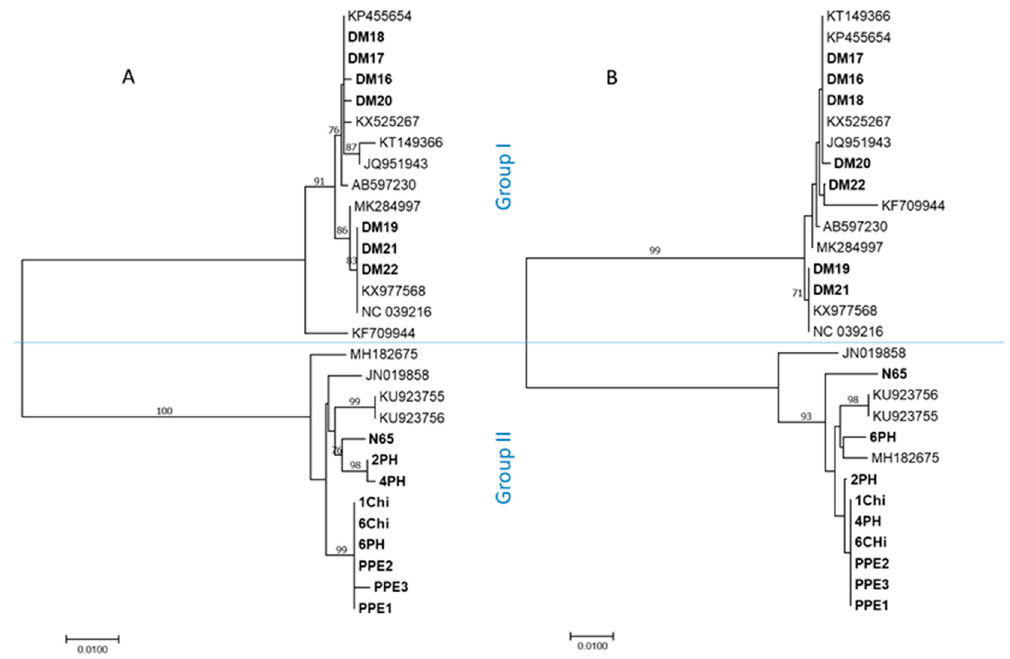
Figure 2. Neighbor-joining phylogenetic tree constructed from alignments of partial bell